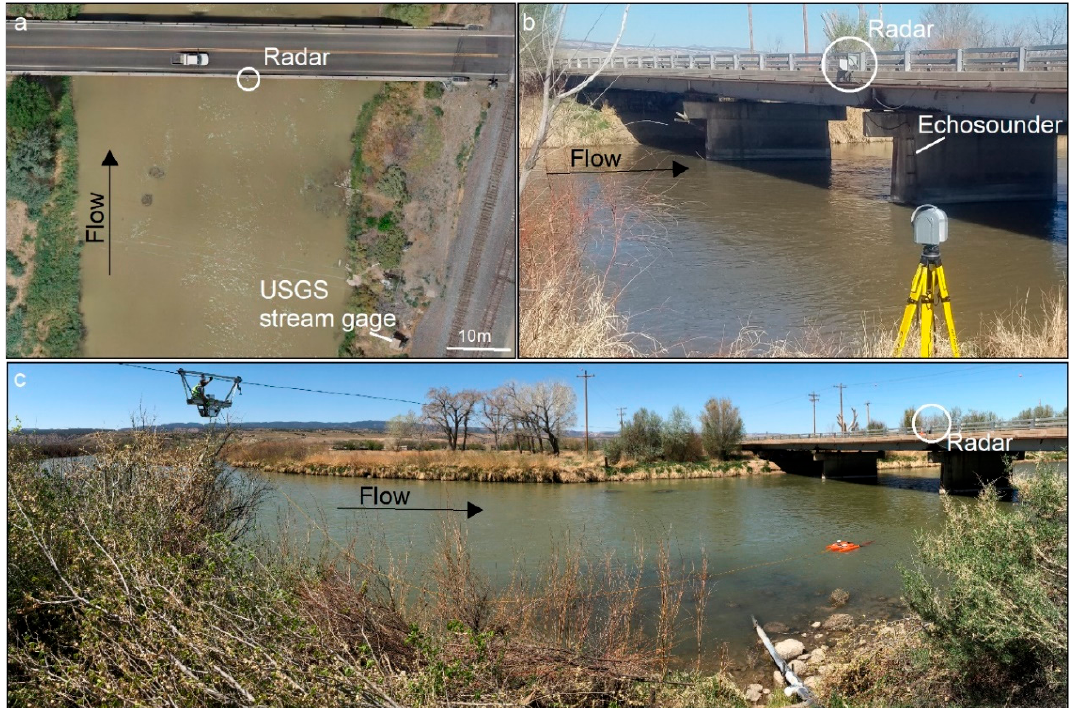
Figure 2. Aerial photos of instrumentation with respect to the Whitewater Bridge taken by Mark Henneberg ( a ); side view of radar and single-beam echosounder mounted to the bridge ( b ); and panorama view of the cableway used to collect discharge measurements adjacent to the USGS streamgage and the Whitewater Bridge ( c ).